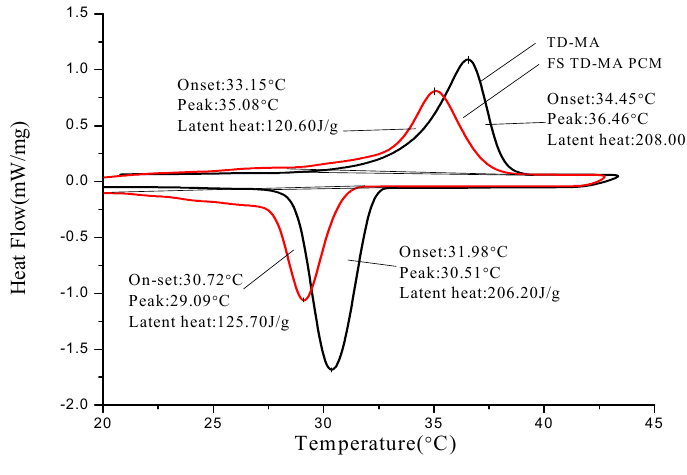
Figure 10. DSC curves of TD-MA eutectic mixture and FS TD-MA PCM. Their onset temperatures, peak temperatures and latent heat are